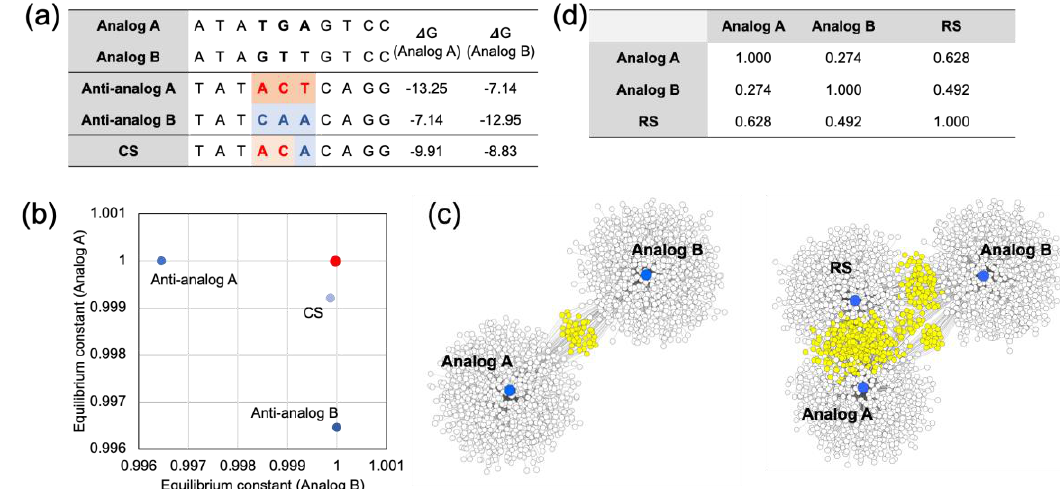
Figure 3. ( a ) The sequence information of the analogs used for calculating the RS. The analogs had three differences in their sequences. A calculated CS was hetero-sequenced for both of the Anti-analogs. The Gibbs free energy values of the sequences show that the CS was not as stable as the Anti-analogs; however, the difference was modest between the two analogs. ( b ) The multiple reaction equilibrium of the CS and Anti-analogs. The equilibrium constant coordinates of the Anti-analogs were biased to their analog, and the distance to the coordinate of perfect hybridization (1,1) (marked with the red dot) was relatively great. Meanwhile, the coordinate of the CS was located closer to the red dot. ( c ) The sociogram mapped with 1000 complementary sequences shows that the RS shared more complementary candidates with the analogs. ( d ) In addition, the Pearson’s correlation coefficients of the Gibbs free energy values against all of the complementary sequences between the analogs and the RS were lower than those of the analogs.